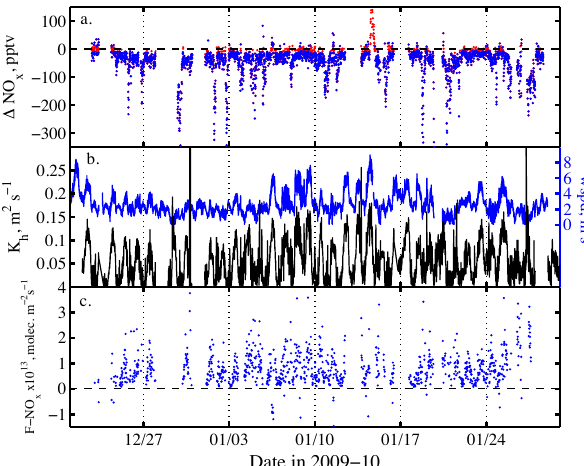
Fig. 7. 10-min averages of NO x flux at Dome C in summer 2009– 2010 between 1.0 and 0.01m: (a) difference in NO x mixing ratios ( 1 NO x ) between 1.0 and 0.01m (blue symbols); values within ± 1- σ standard error were excluded from the flux calculation (red sym- bols), (b) turbulent diffusion coefficient of heat ( K h ) at 1m and wind speed (wspd) at 3m, and (c) NO x flux (F-NO x ).